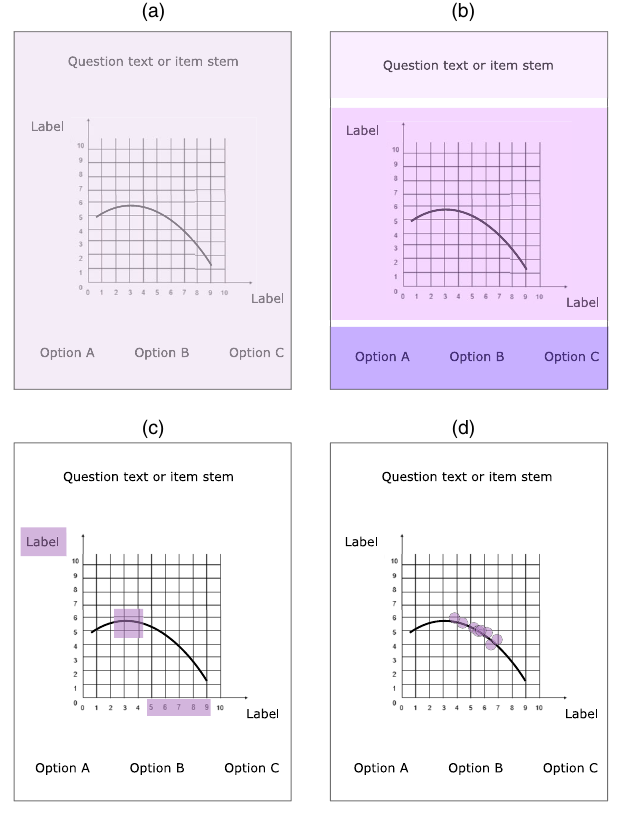
FIG. 2. Illustration of global and local analyses of a visual stimulus (RQ2). For (a) – (d), the figure shows the identical visual stimuli, comprising a question text, a diagram, and response options. We use the term global analysis when, for example, gaze behavior is considered on the whole stimulus (a). The subdivision into surface features of the task format (b) is also considered as a global analysis. If, on the other hand, task-relevant elements within a representation are considered, we use the term local analysis (c). This includes task-relevant or irrelevant areas, or areas that are of special interest for the research question under investigation. Also, when the temporal evolution of gaze behavior is considered within a representation, for example, whether eye movements follow the graph, we refer to this as a local analysis